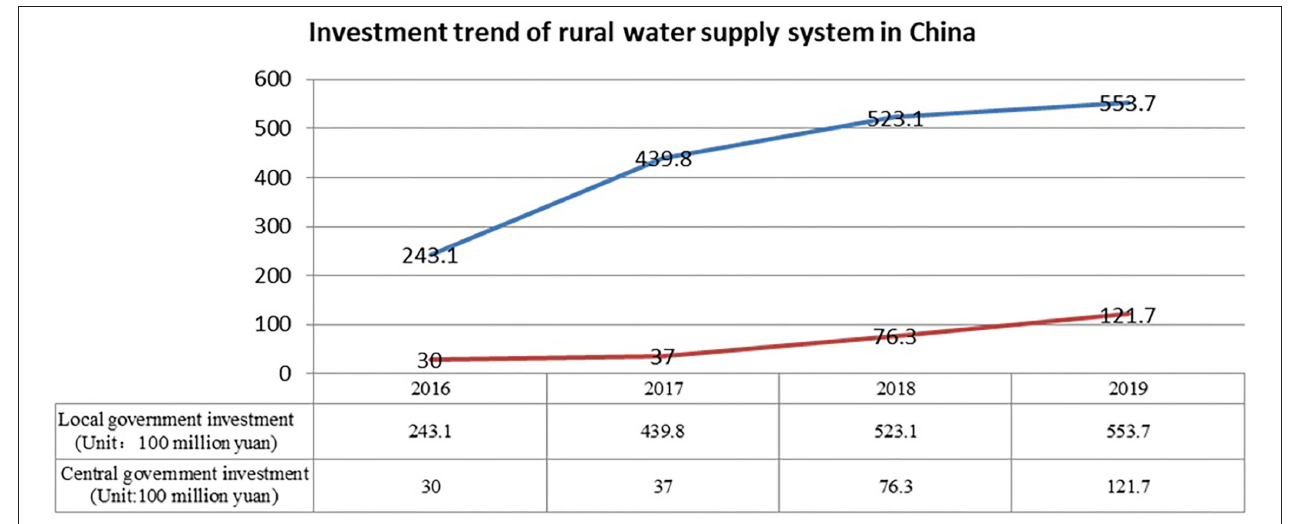
FIGURE 1 | The investment trend of rural water supply systems (RWSSs) in China from 2016 to 2019 (Data sources: Ministry of water resources of China).